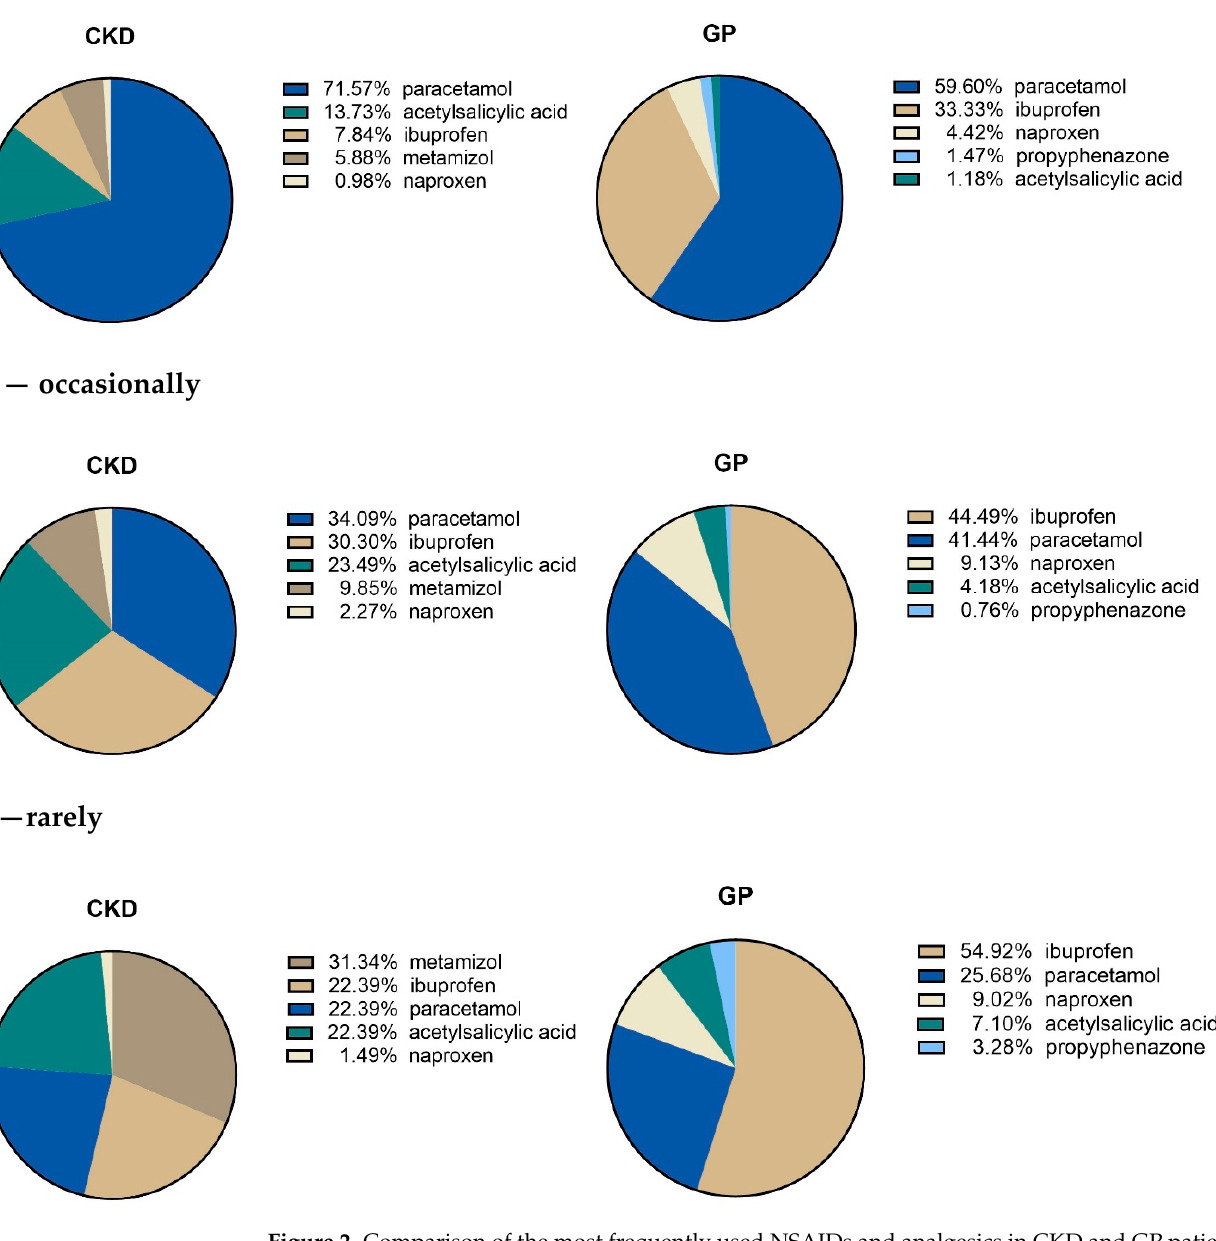
Figure 2. Comparison of the most frequently used NSAIDs and analgesics in CKD and GP patients, based on the Patients’ answers to question 3 (which of the listed drugs are you taking?/please provide the names of analgetic drugs you used–from the most to the least frequently used). Table 5. Statistical evaluation of the most frequently used NSAIDs and analgesics in CKD and GP patients.